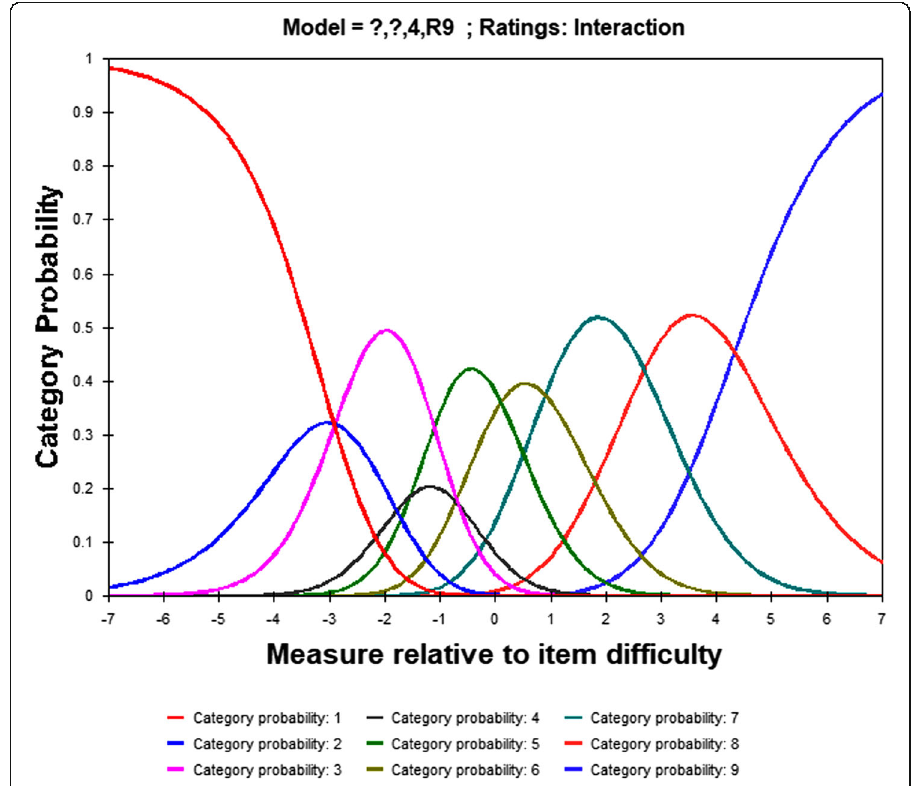
Fig. 2 Category probability curves for the 9-point interaction